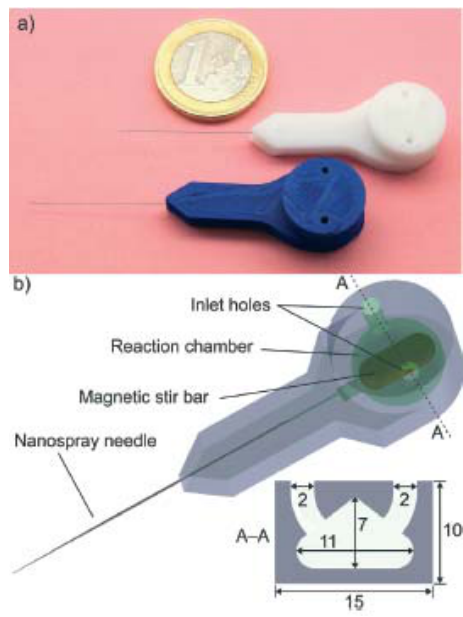
Figure 13. ( a ) 3D printed reactors from white and blue PP. PP weak mechanical properties and poor adhesion to most built platforms are compensated by the fact that it is inert and resistant to many inorganic and organic reagents and solvents; ( b ) functional parts and cross ‐ section of the reaction chamber, dimensions in millimeters. (Reproduced with permission from [19].)